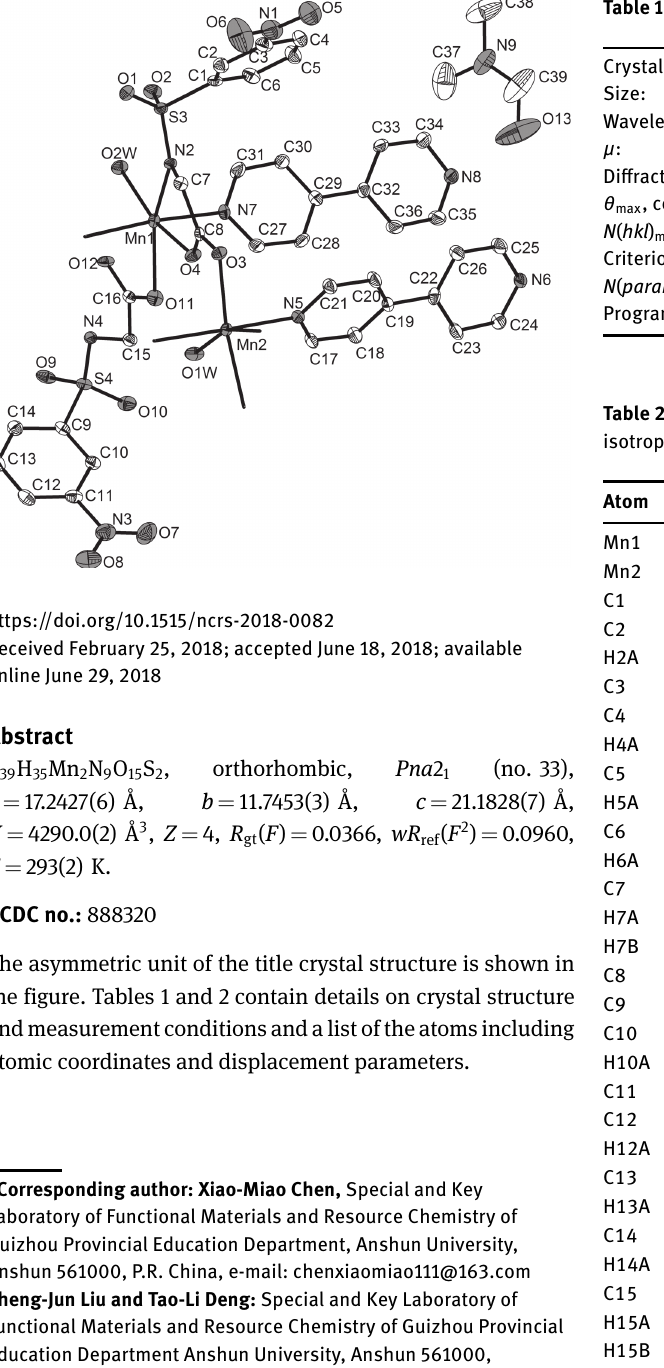
Table 1: Data collection and handling.